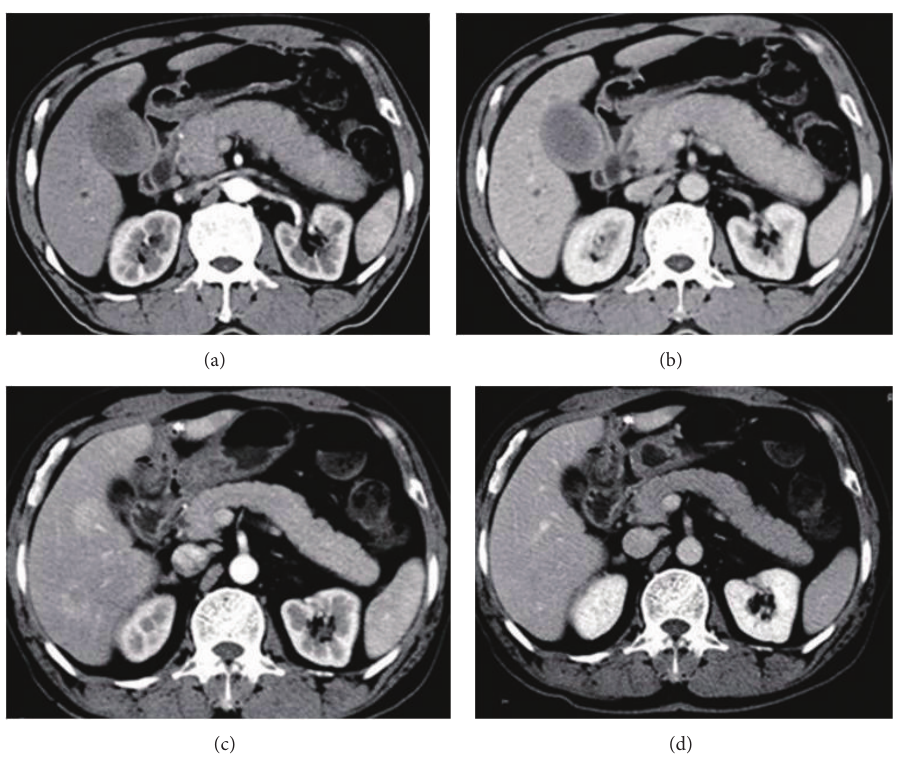
Figure 1: Imaging changes before and after steroid therapy in patient No. 6. Pretreatment: the arterial phase (a) and venous phase (b) of contrast-enhanced computed tomography both revealed a diffusely swollen pancreas with a “capsule-like rim” and “sausage-like” appearance. After internal drainage and a 3-month steroid therapy, the arterial phase (c) and venous phase (d) of contrast-enhanced showed that the swollen status of pancreas had been obviously